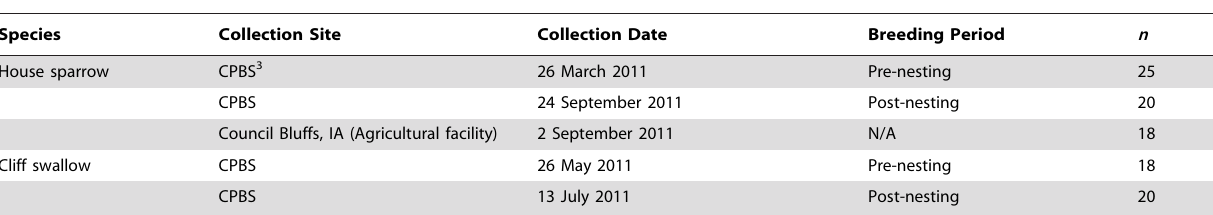
Table 1. Sampling